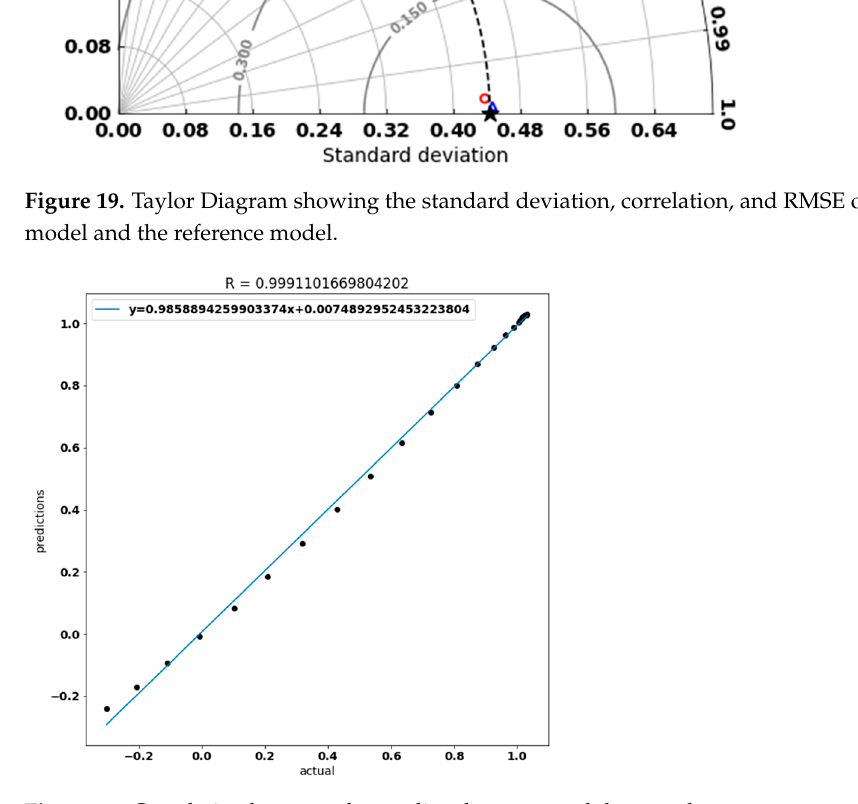
Figure 20. Correlation between the predicted current and the actual measurements.